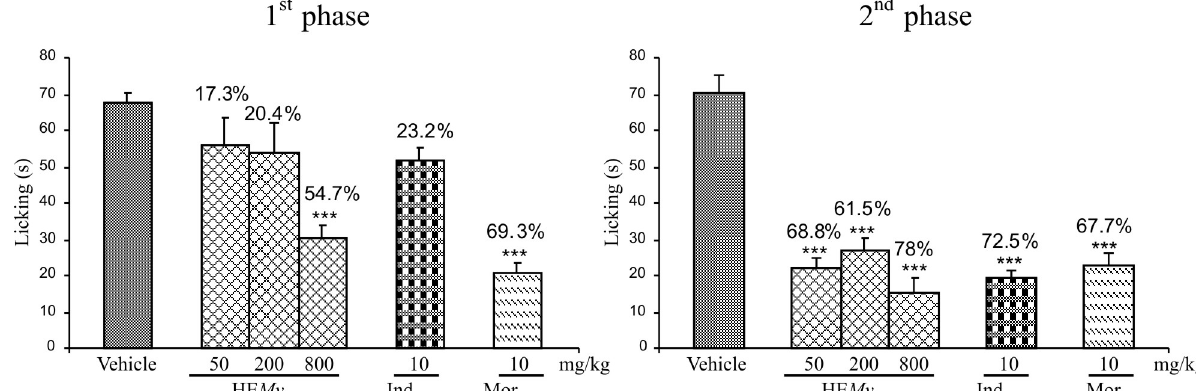
FIGURE 6 - Effect of hydroethanolic extract of M. velame on the 1 st and 2 nd phases of pain induced by formalin injection in mice. Each value is the mean ± S.E.M. of 8 rats. ***p<0.001 compared with control. One-way ANOVA followed by Student-Newman–